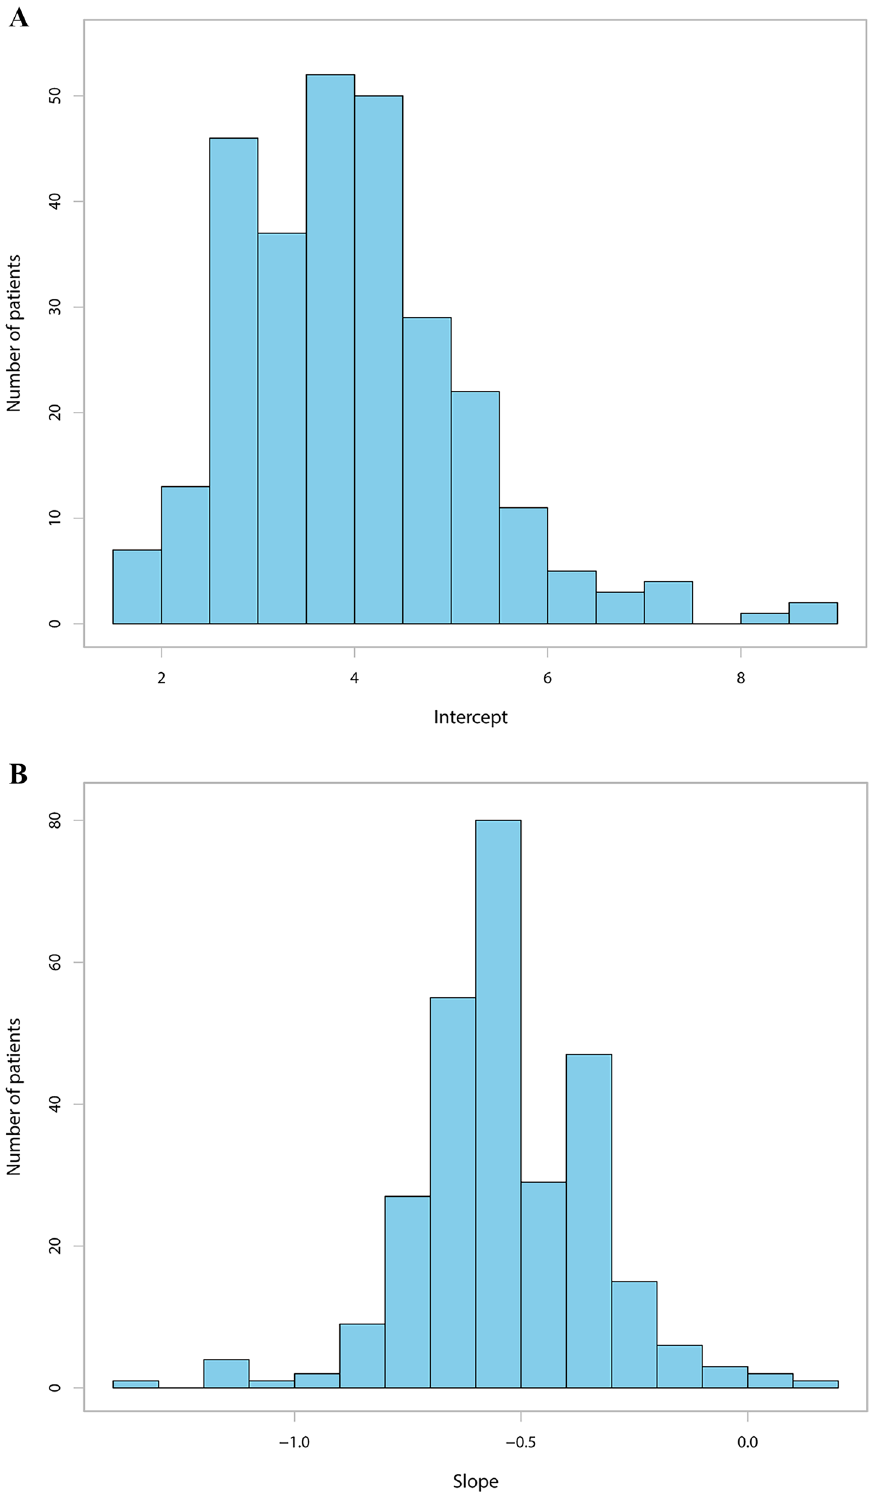
Figure 2. ( A ) Distribution of the APSP trajectory intercept. ( B ) Distribution of the APSP trajectory slope. APSP Acute postsurgical